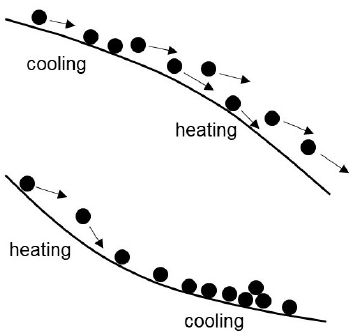
Figure 5. Cartoon of hillslope surfaces with downslope variations in steepness leading to concomitant variations in heating, cooling and deposition; this is in contrast to a planar slope with uniform µ that produces either net heating or net cooling, or isothermal condi- tions.